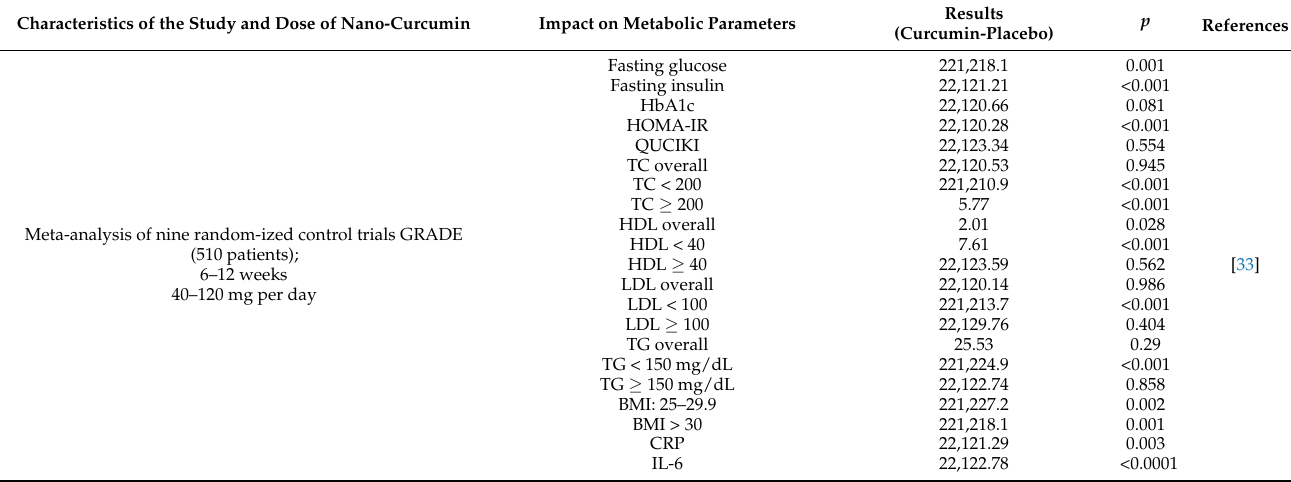
Table 4. The results of nano-curcumin supplementation in nine randomized controlled trials on metabolic parameters predicting risk for cardiovascular disease. Characteristics of the Study and Dose of Nano-Curcumin Impact on Metabolic Parameters Results p References